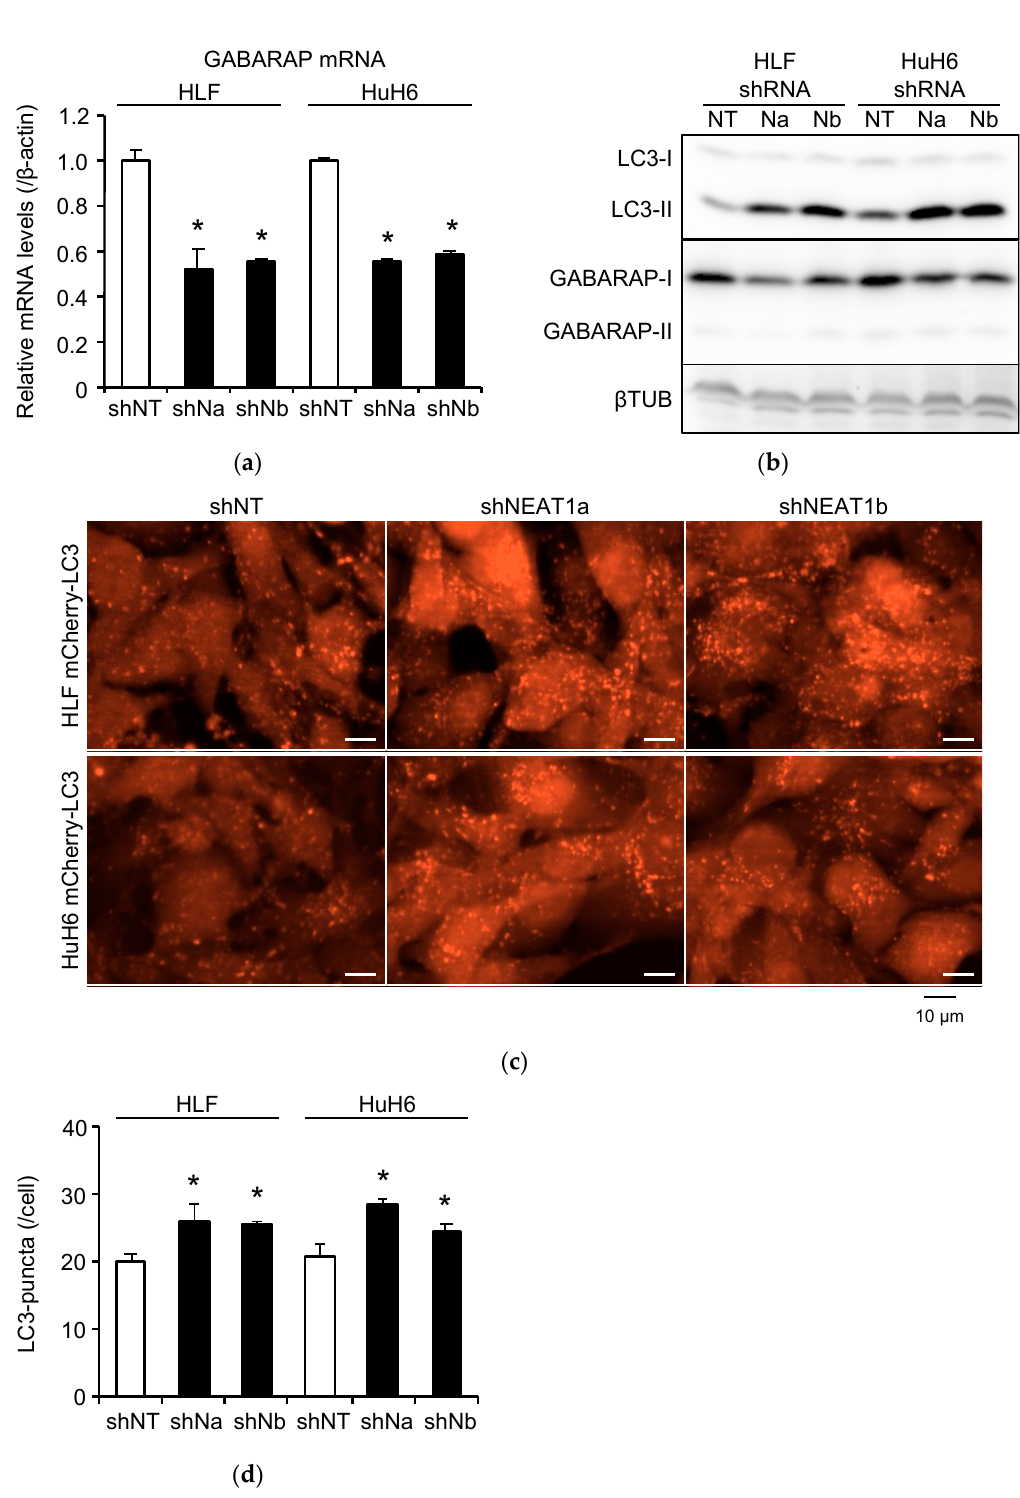
Figure 3. Inhibition of autophagy by NEAT1 knockdown in HCC cell lines. ( a ) GABARAP mRNA expression levels in HLF and HuH6 cells transduced with shNT, shNEAT1a (shNa), or shNEAT1b (shNb) for 48 h. * p < 0.05 vs. shNT; Dunnett’s test ( n = 3). ( b ) LC3 and GABARAP protein expression in HLF and HuH6 cells transduced with shNT (NT), shNEAT1a (Na), or shNEAT1b (Nb) for 48 h. The internal control was β TUB. ( c , d ) Representative images ( c ) and relative number ( d ) of LC3 puncta in mCherry-LC3-expressing HLF and HuH6 cells transduced with shNT, shNEAT1a (shNa), or shNEAT1b (shNb) for 48 h. * p < 0.05 vs. shNT; Dunnett’s test ( n = 4).